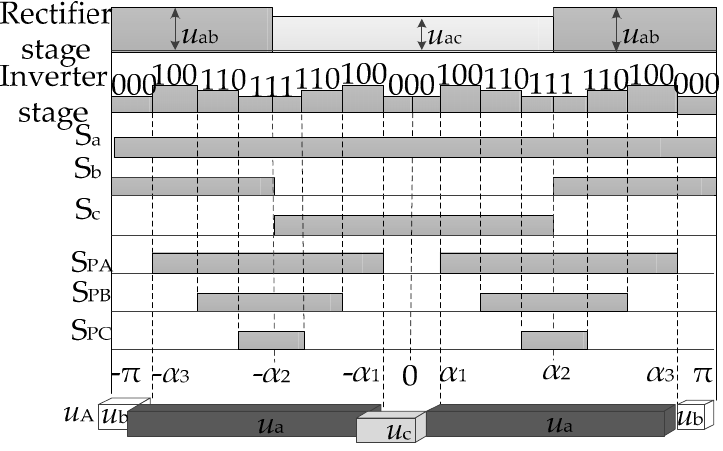
Figure 3. Modulation process when both I ref and V ref are in the first sector.